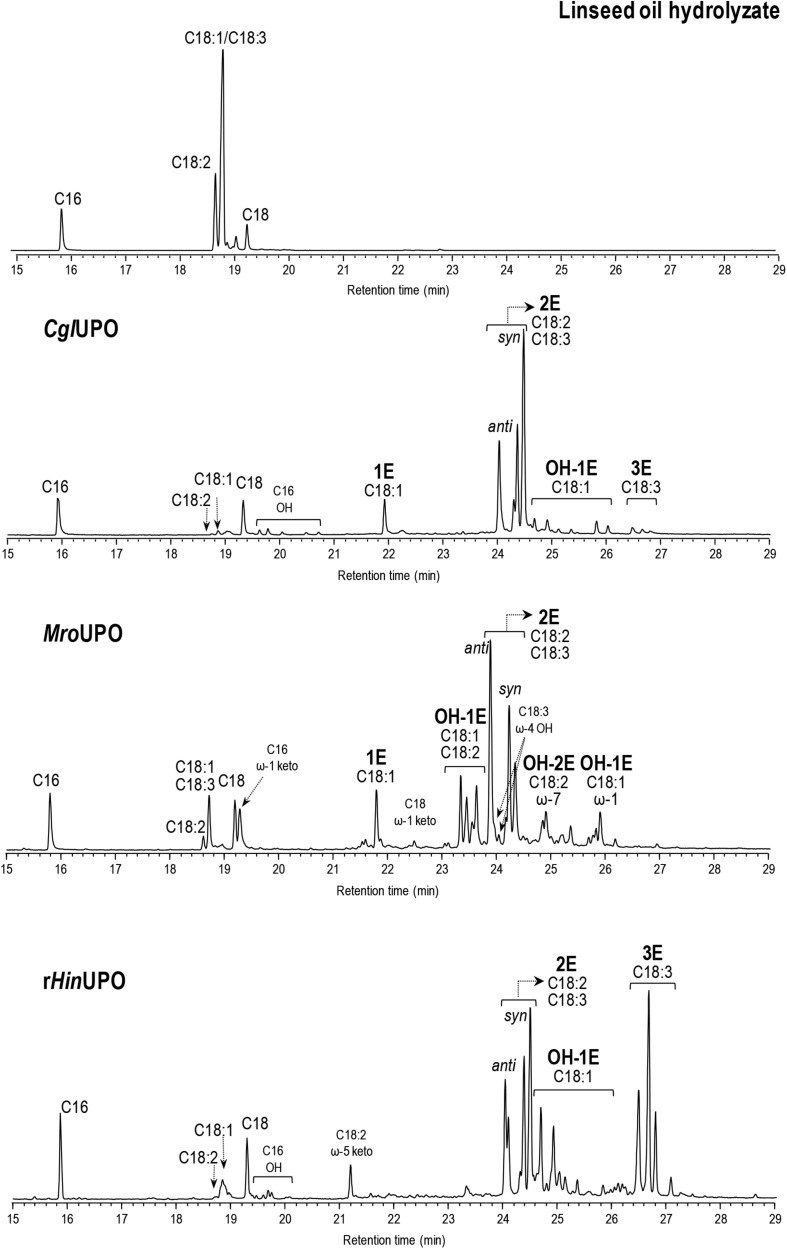
GC-MS analysis of linseed oil hydrolyzate (0.1 mM total fatty-acid concentration) reactions with CglUPO, MroUPO, and rHinUPO (200 nM), showing monoepoxides, diepoxides (including syn and anti isomers from linoleic acid), and triepoxides (1E, 2E, and 3E, respectively), and other oxygenated (hydroxy, OH, and keto) derivatives. Control chromatogram is also shown (in the top). The oleic and α-linolenic peaks partially overlap under the optimized conditions for analysis of their oxygenated products, and quantitation was done using specific ions.